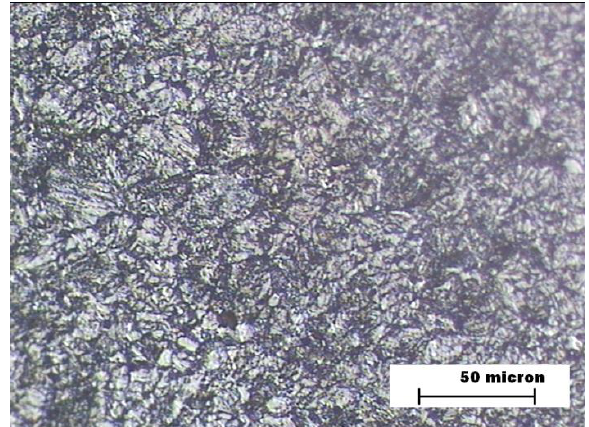
Figure 6. Sample B. HAZ microstructure.